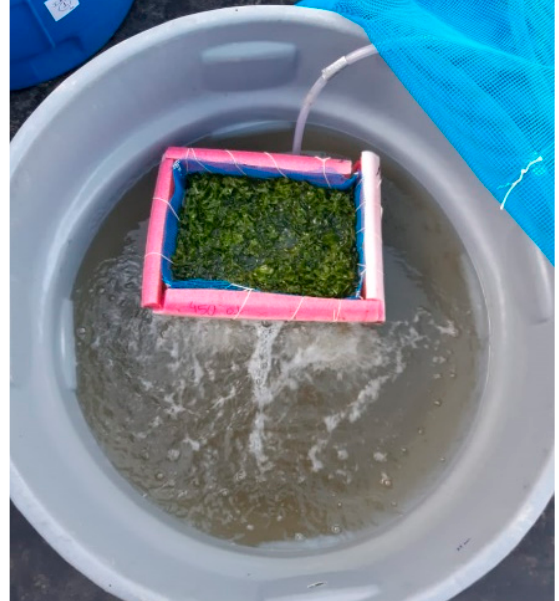
Figure 1. The rectangular floating structure used for U. lactuca cultivation in the shrimp tank.